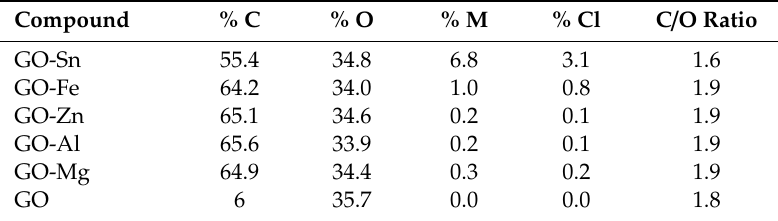
Table 1. Atomic composition (XPS) of: (a) GO-Sn; (b) GO-Fe; (c) GO-Zn; (d) GO-Al; (e) GO-Mg; and (f) GO